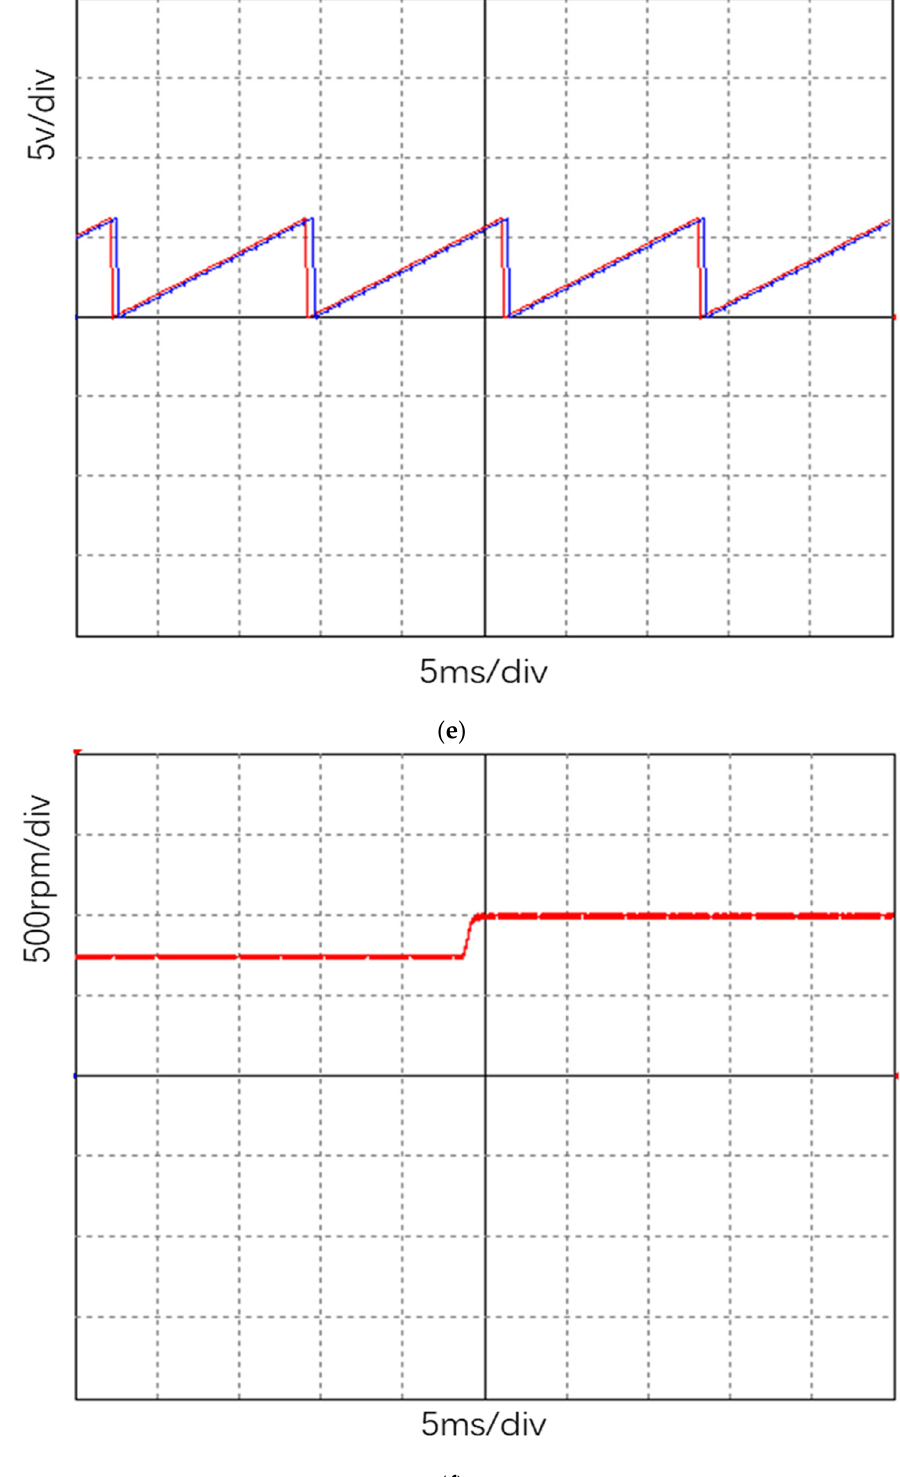
Figure 14. Waveform detected by human–machine interface. (a) Three-phase stator current waveform; (b) Clark transformed current; (c) SVPWM output waveform; (d) waveform diagram of actual speed and reference speed; (e) actual and estimated position of the rotor; (f) dynamic performance when changing the reference speed.